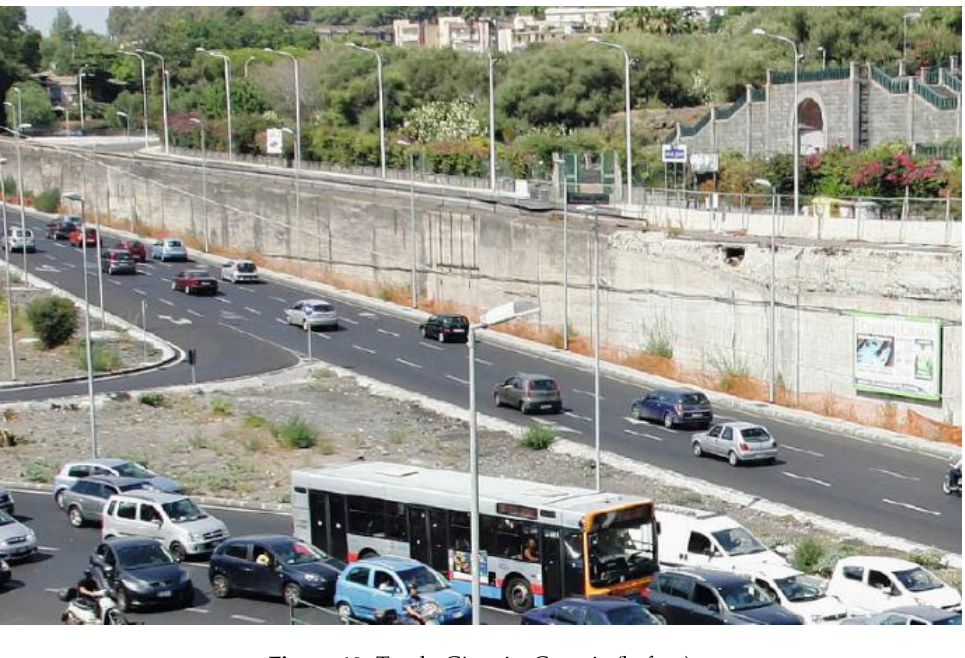
Figure 10. Tondo Gioeni—Catania (before).